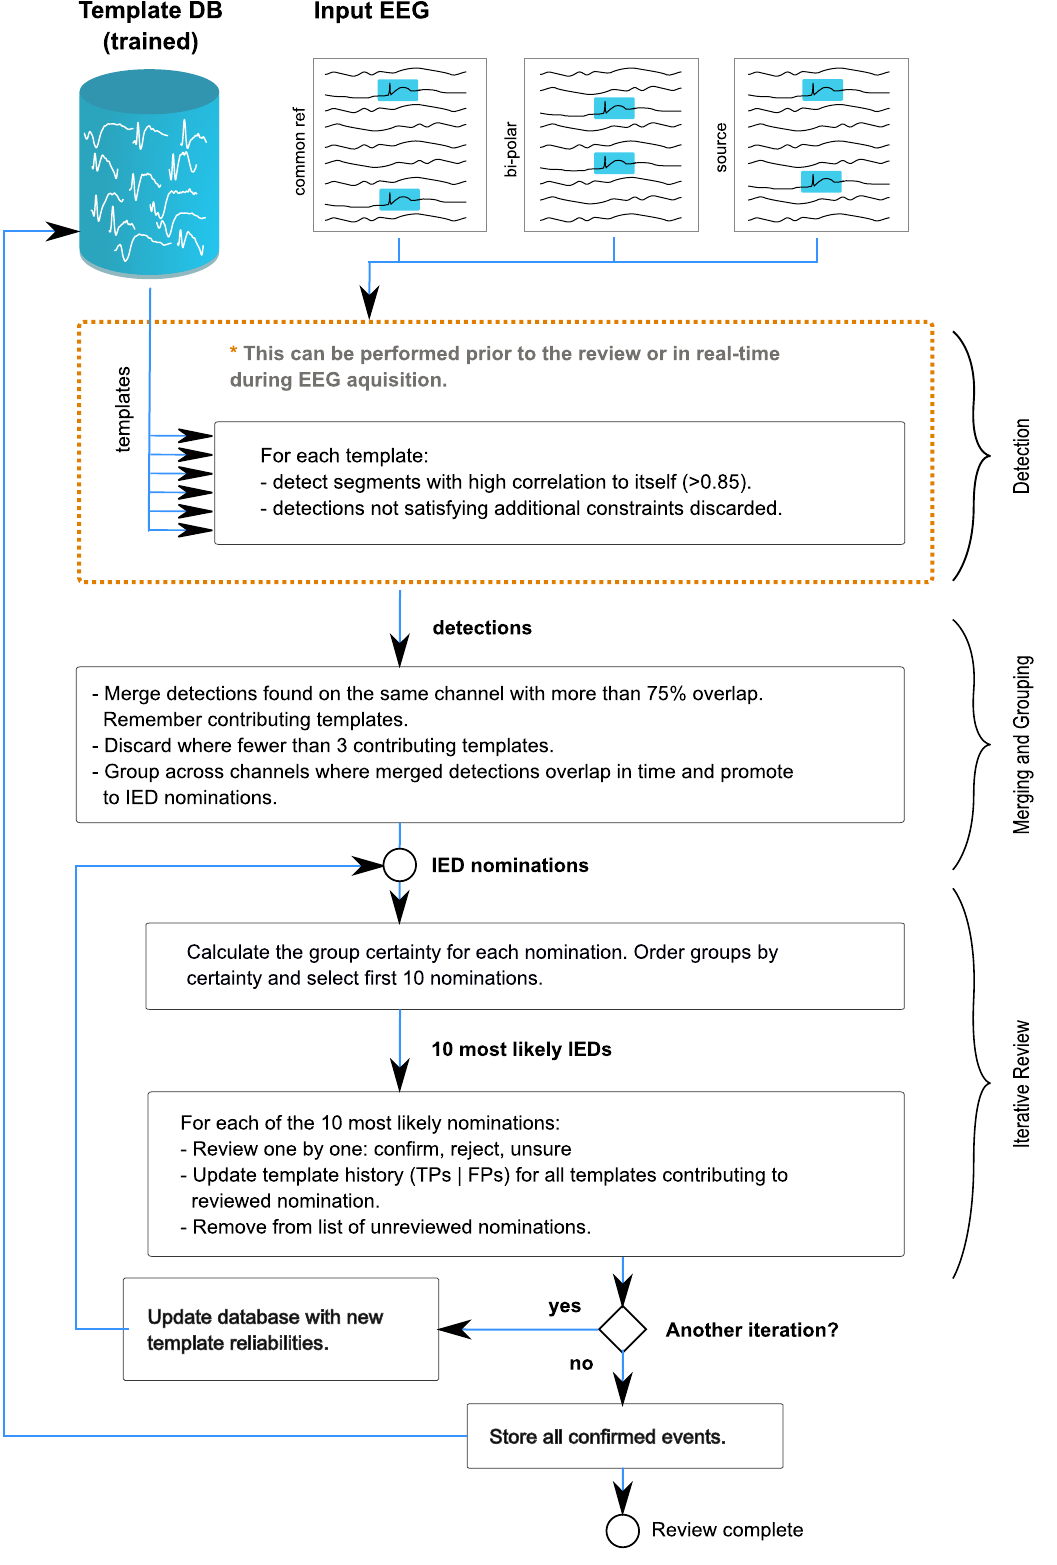
Figure 2. Outline of the IED detection, grouping, and presentation steps. Multiple detections of inter-ictal activity are made using a database of matching template waveforms. Individual template detections are merged and grouped (see Fig. 3) to form IED nominations, and the nominations are presented for review in an iterative manner, ordered by nomination certainty.